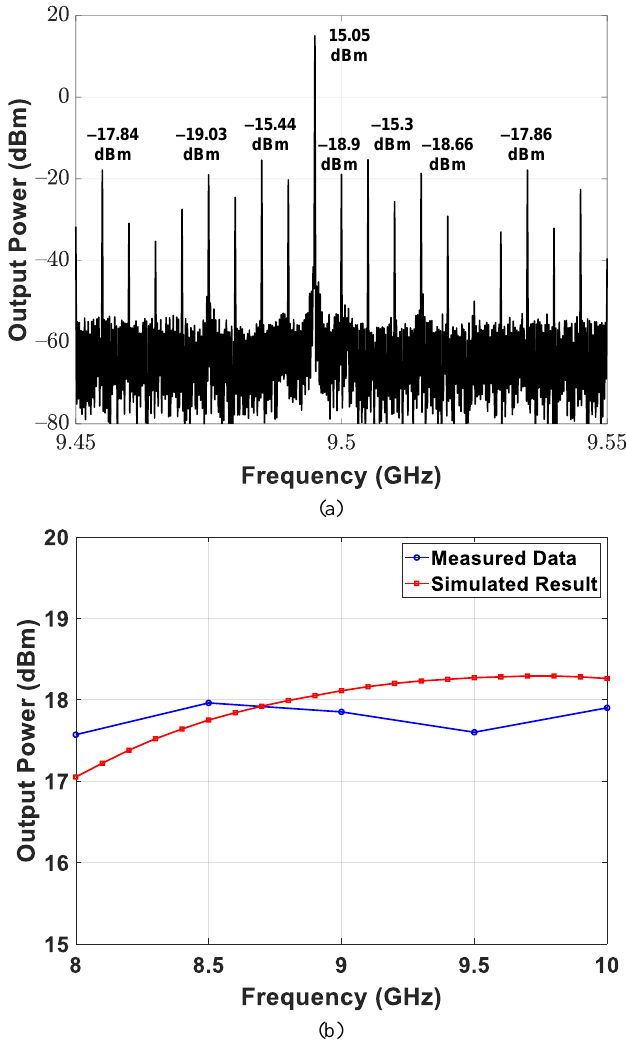
Figure 25. Circuit performance of the implemented transmitter, including ( a ) output spectrum at 19 GHz LO and 5 MHz baseband input frequencies, ( b ) saturated output